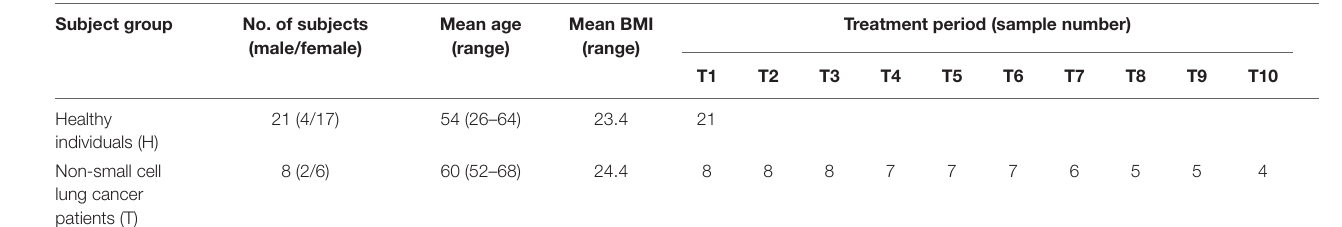
TABLE 1 | Characteristics of the study subjects and the